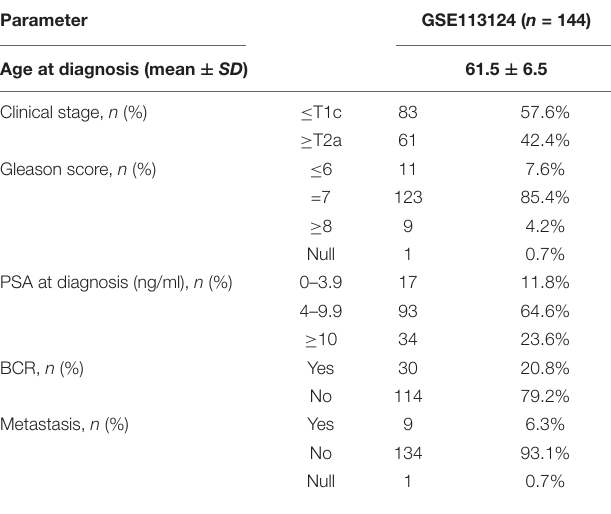
TABLE 1 | Clinical characteristics of the prostate cancer